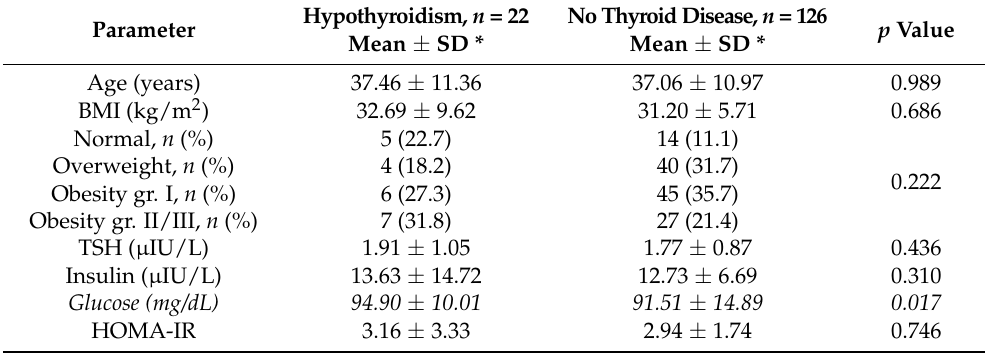
Table 4. Demographic, anthropometric and laboratory data in the non-Hashimoto’s hypothyroidism group and in women without thyroid disease. Significant differences are emphasized in italics.